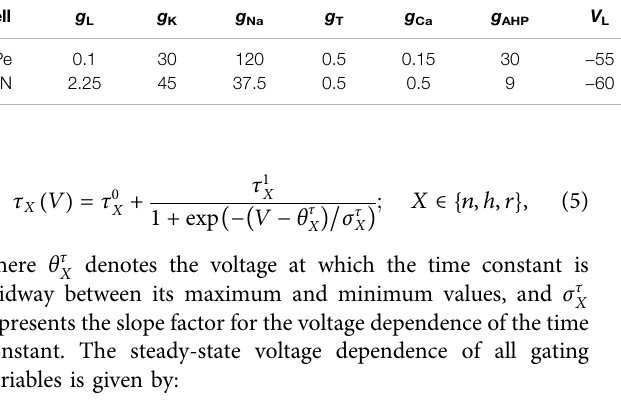
TABLE 1 | Parameters used for maximal conductances ( g X in nS/ μ m 2 ), neuronal and synaptic reversal potentials ( V X in mV), and calcium dynamics for GPe and STN neuron models. Cell g L